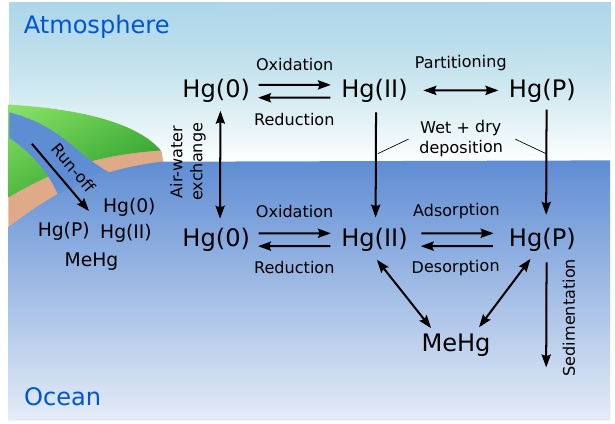
Figure 1. General scheme of mercury transformations in the